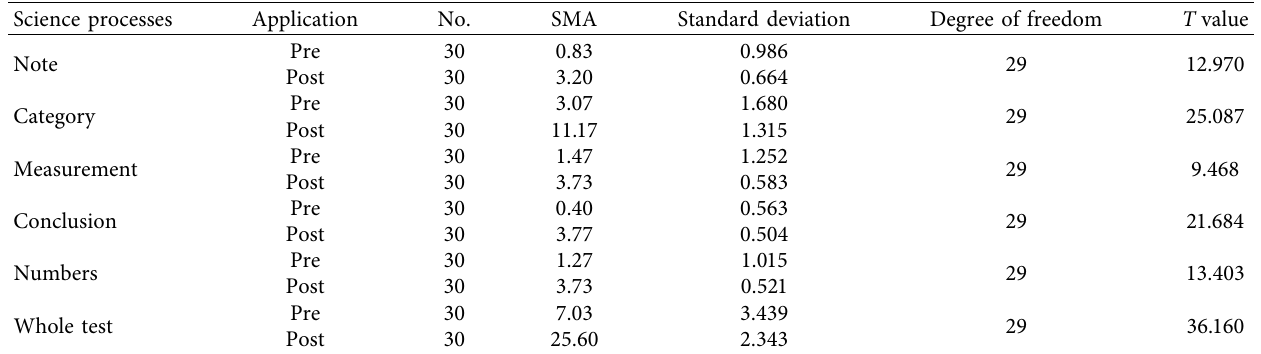
Statistical significance level � 0.000.